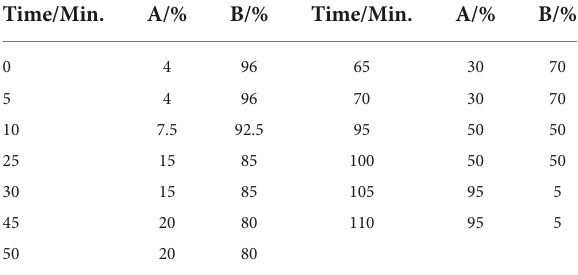
TABLE 1 Mobile phase gradient elution procedure.